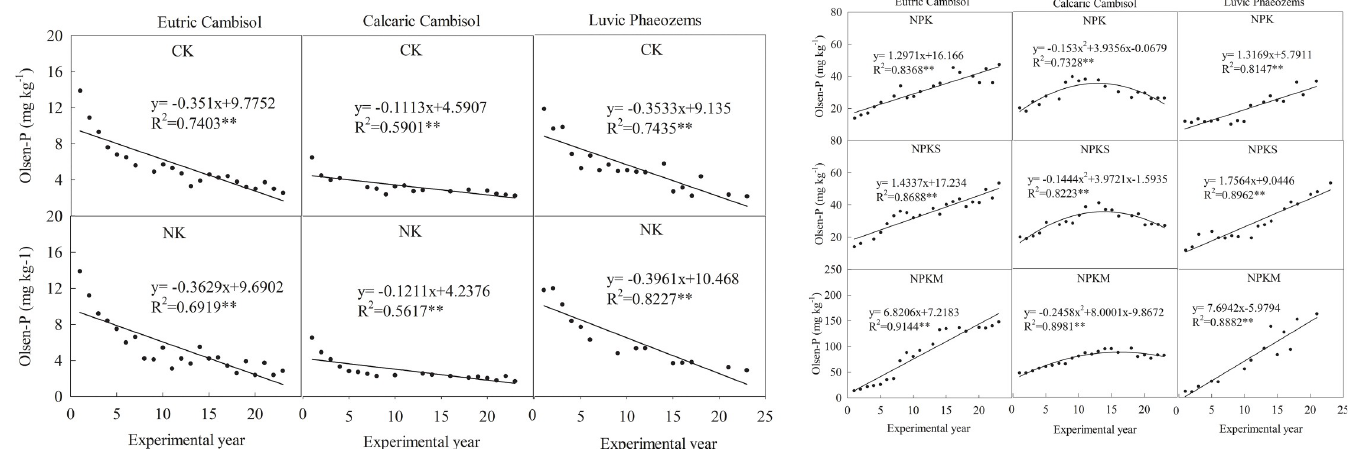
Fig 3. Change in soil Olsen-P over time in response to different fertilization treatments. CK: unfertilized control; NK: nitrogen and potassium; NPK: nitrogen, phosphorous, and potassium; NPKS: nitrogen, phosphorous, potassium and straw; and NPKM: nitrogen, phosphorous, potassium and manure (NPKM).